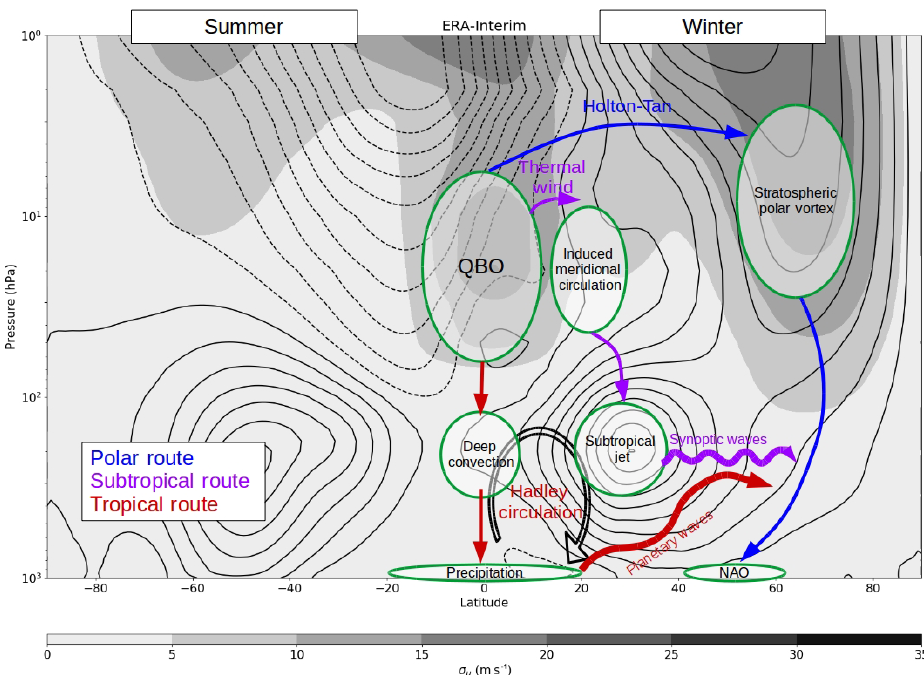
Figure 1. Schematic summarizing the three primary routes (tropical, subtropical, polar) for QBO influence at the Earth’s surface. Contours show the December–January–February averaged, zonally averaged zonal winds for 1979–2016 from ERA-Interim data. The contour interval is 5ms − 1 ; solid contours denote westerlies; dashed contours denote easterlies. Greyscale shows the standard deviation of the zonal winds in ms − 1